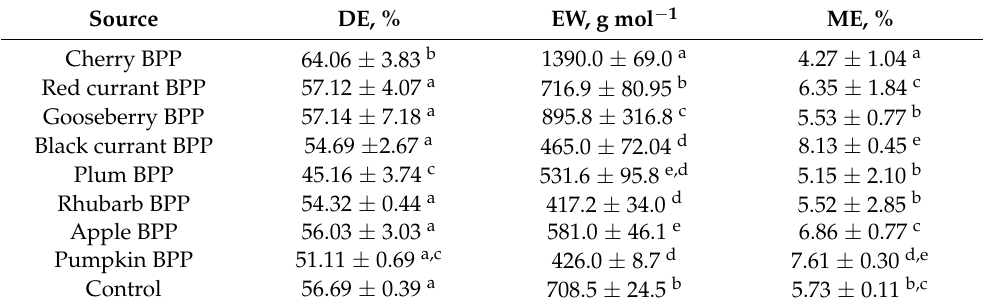
Table 3. Properties of pectin obtained from juice extraction and primary food production